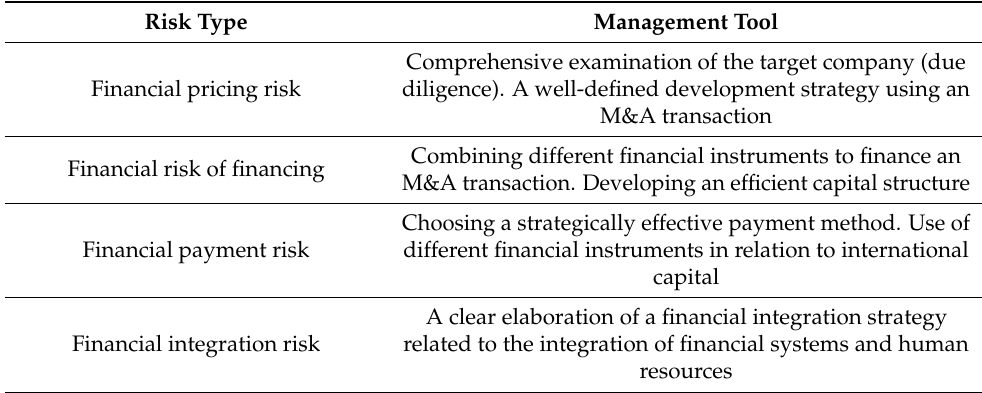
Table 1. Management tools for various types of risk (Sui and Dumitrescu-Peculea